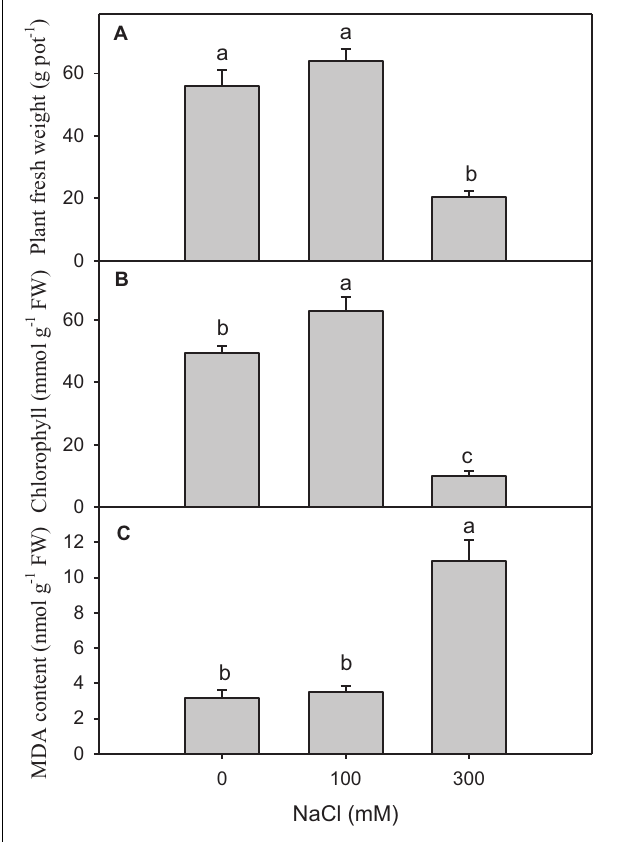
FIGURE 1 | Physiological and biochemical changes in salt-treated Panicum antidotale . (A) The fresh weight of plants (B) The chlorophyll content in the leaves and (C) malondialdehyde (MDA) content in plants treated with 0, 100, and 300 mM NaCl ( n = 3 ± SD ). The different letters present the significant difference among treatments at the P < 0.5 after the Bonferroni post hoc